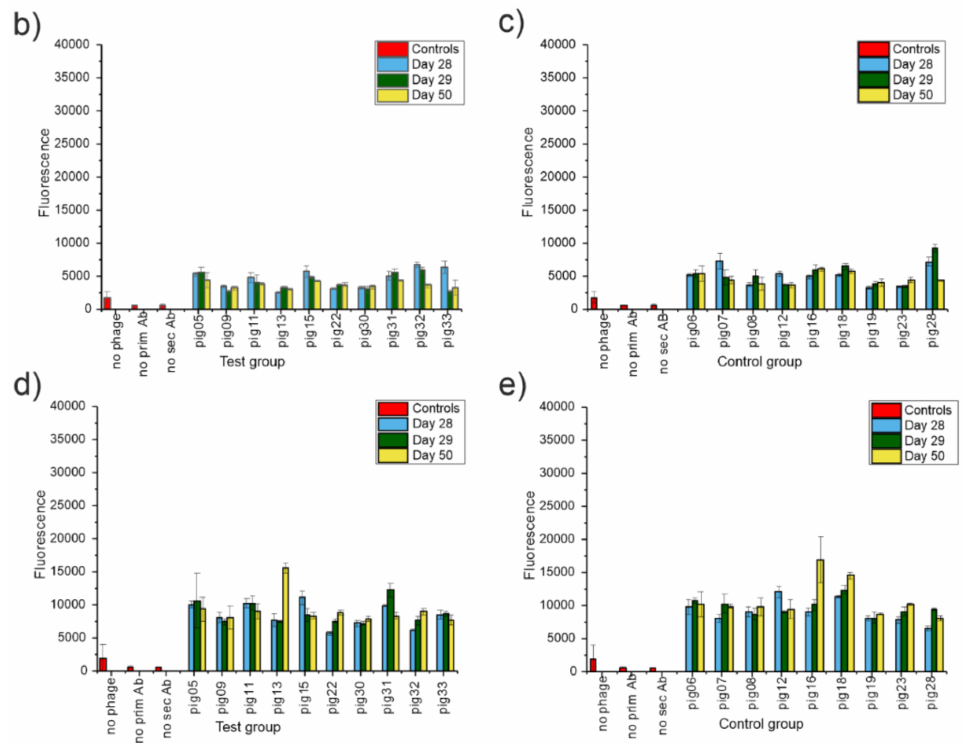
Figure 3. An in-house ELISA assay for the detection of phage-specific antibodies in serum samples. ( a ) The detection of Φ YeO3-12 specific antibodies in rabbit antiserum in wells coated with 5 × 10 9 PFU and 1 × 10 10 PFU of purified phage Φ YeO3-12. The result shown is a mean of two measurements. ( b ) The detection of mEBHT antibodies in phage group animals. ( c ) The detection of mEBHT antibodies in control group animals. ( d ) The detection of fRuSau02 antibodies in phage group animals. ( e ) The detection of fRuSau02 antibodies in control group animals. Negative controls included the assay performed with no phage used for coating and no primary or secondary antibody used for detection. In ( b – e ), the results shown are means of three measurements and the error bars indicate standard